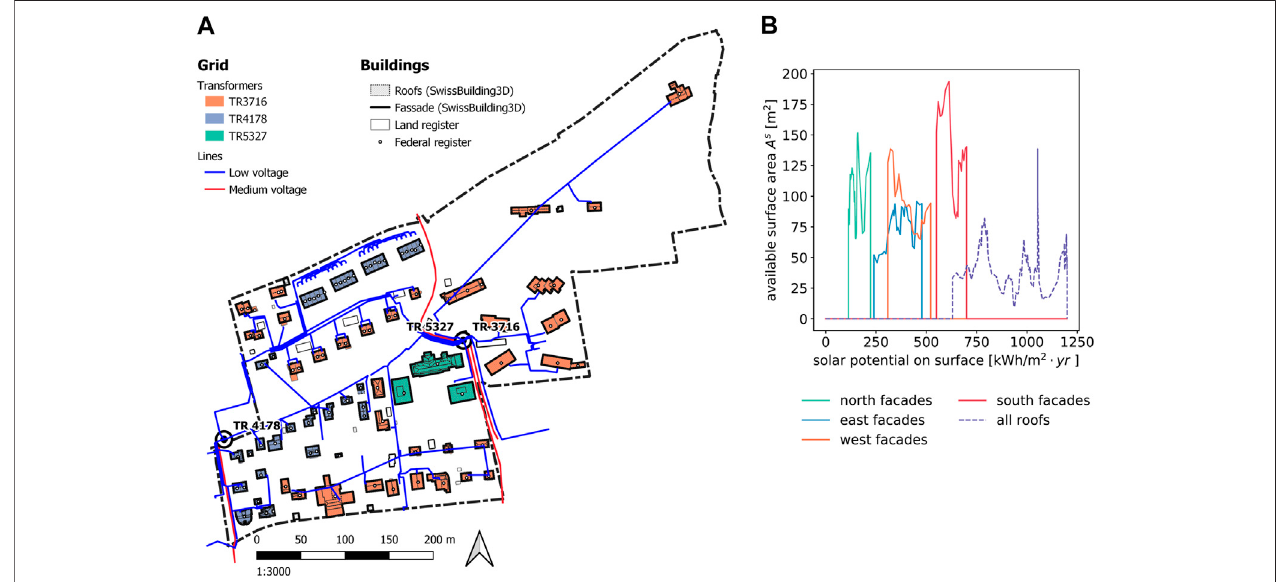
FIGURE4| Details ofthecase-studyarea. (A) Map ofthearea, atypical central Europeanperiurban residential area. (B) SolarPVpotentialon roofand facade asa function of the orientation.